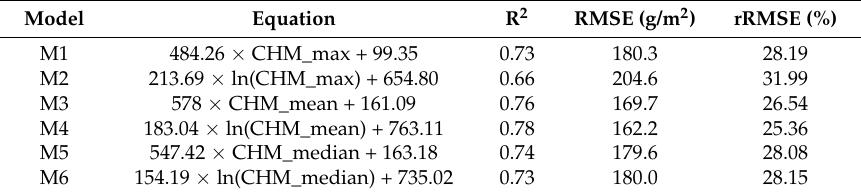
Table 4. The validation results of the six aboveground biomass estimation models. The comparison between predicted aboveground biomass and field measured biomass by using the validation dataset.